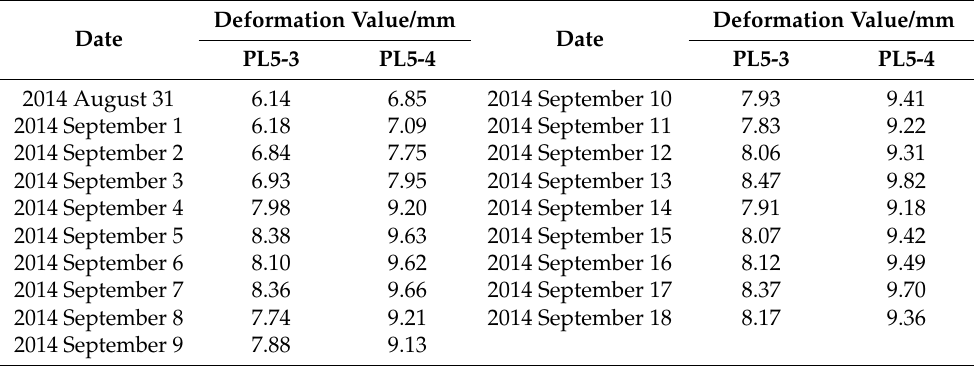
Table 2. Summary table of deformation data of target measurement points and reference measure- ment points.